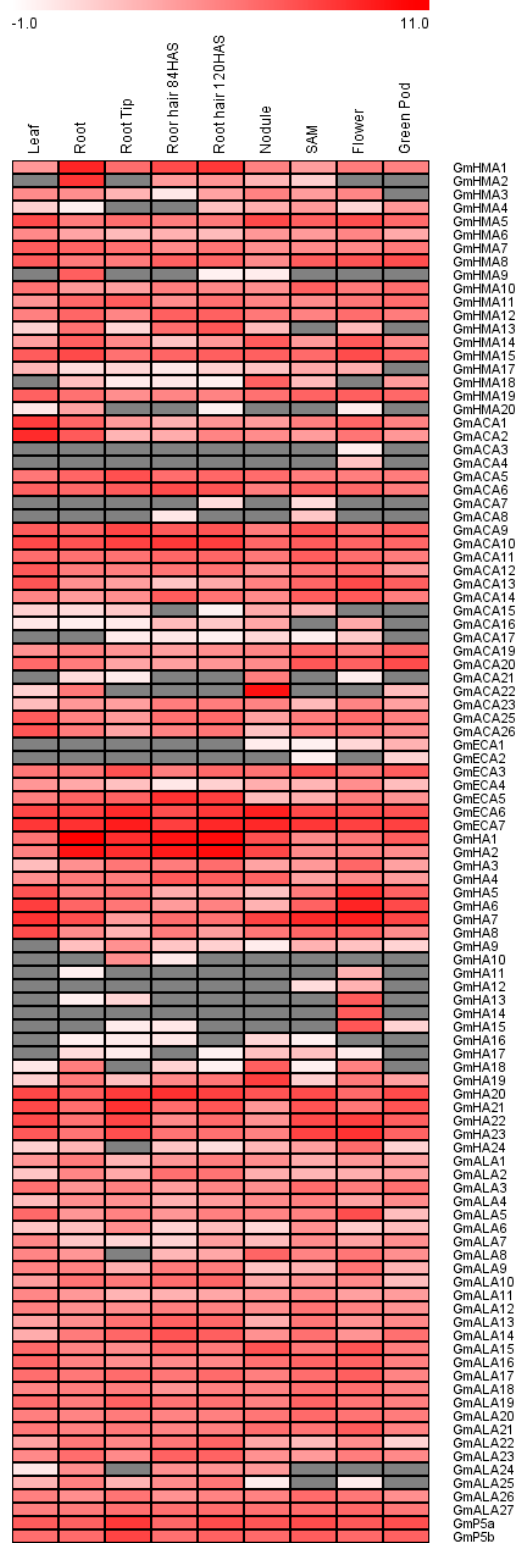
Figure 11. Heat map representation for tissue expression patterns of the putative P-type ATPase superfamily genes in soybean according to Illumina transcriptome data: the Reads/Kb/Million (RPKM) normalized log2 transformed counts were visualized in the heat map. The red colors indicate expression intensity, and grey color indicates no detected expression. HAS: hours after sowing. SAM: shoot apical meristem.